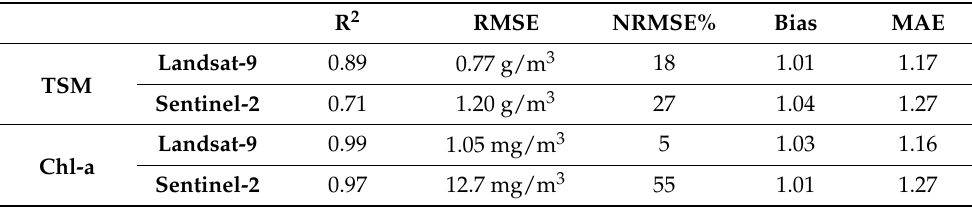
Table 4. In situ matchup validation of TSM (6 samples) and Chl-a (9 samples) retrievals via BOMBER from Landsat-9 and Sentinel-2 imagery in the studied lakes.